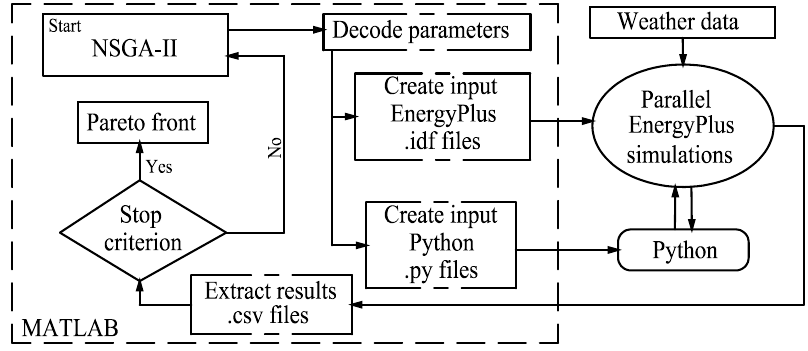
Figure 4. Flowchart diagram for the optimization tool.